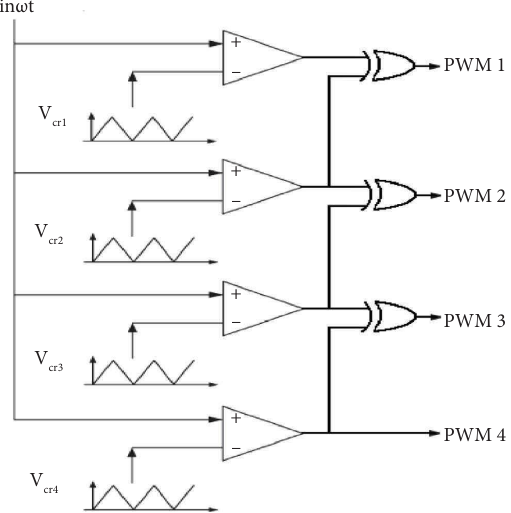
Figure 15: Simplifed modulation scheme for single-phase 9-level inverter.